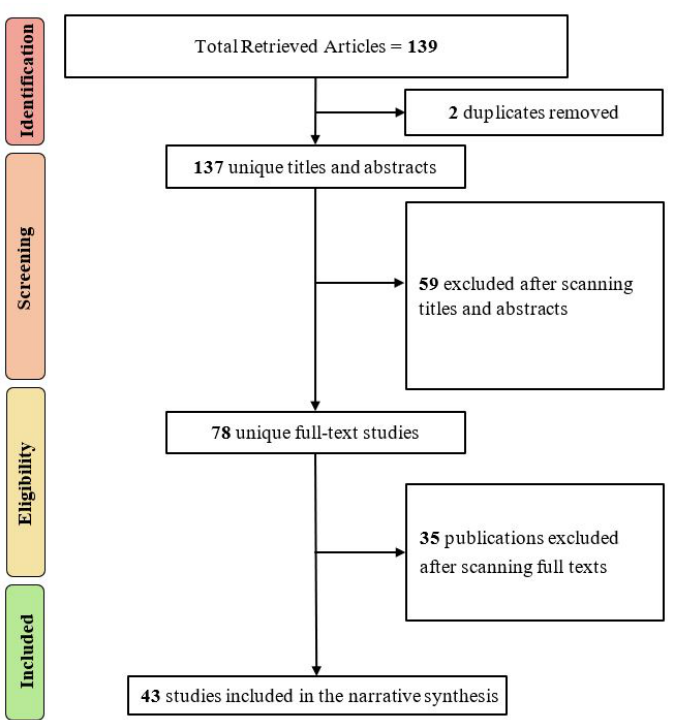
Figure 3. Study selection